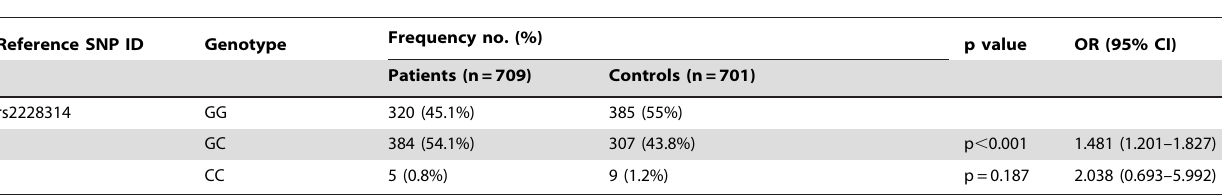
Table 1. Genotypes of 1784G . C (rs2228314) polymorphism in SREBP-2 gene.